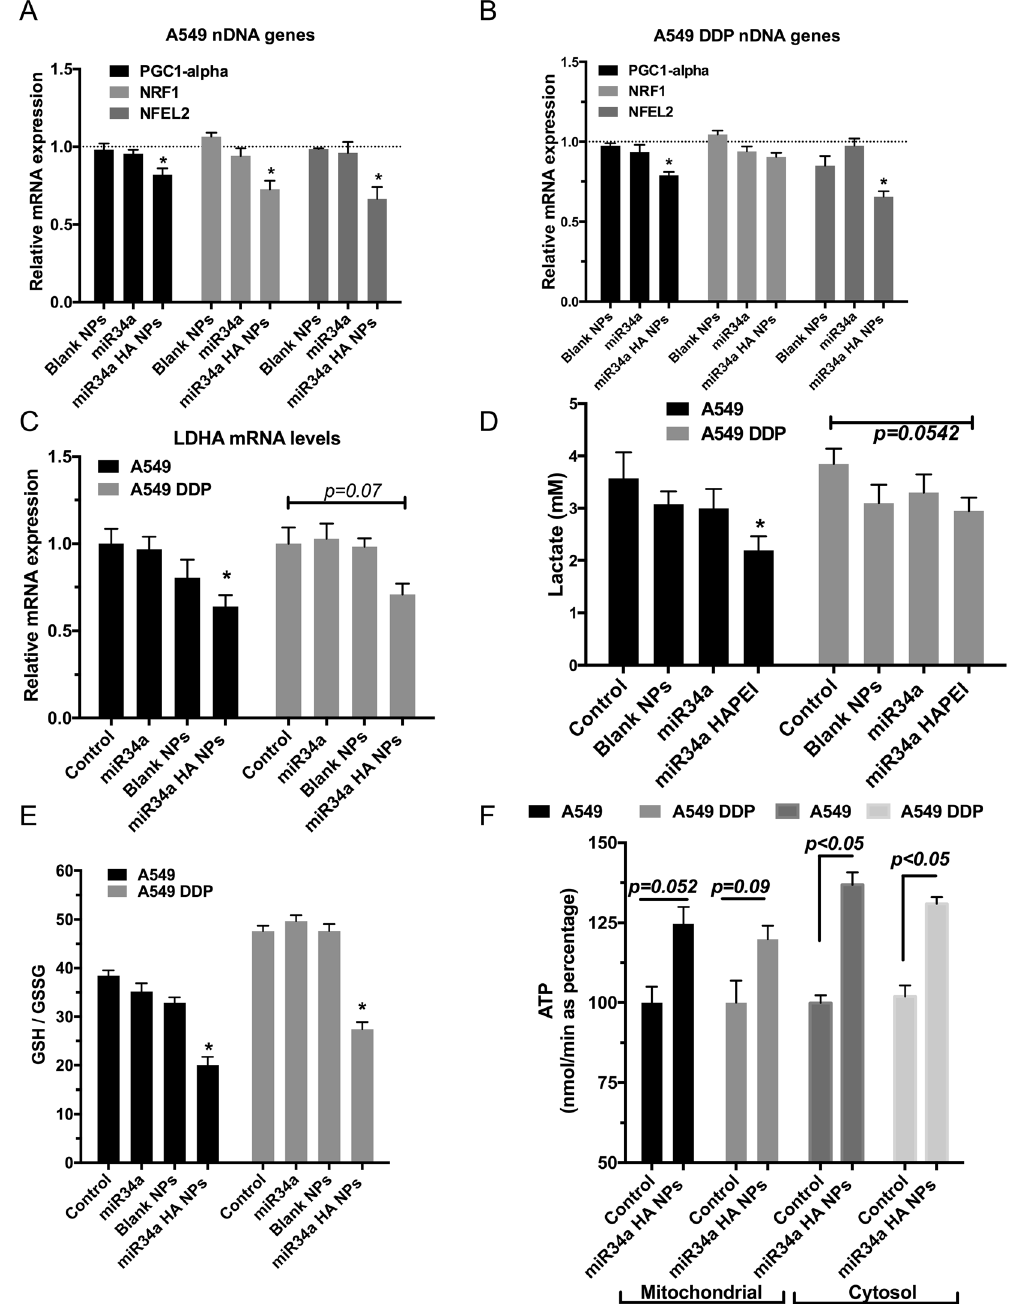
Figure 7. Effect of miR34a transfection with HA-based nanoparticles (50 nM; 24 hours) on mitochondrial bioenergetics and mitochondrial genes encoded on nuclear DNA. A quantitative real time polymerase chain reaction (qRT-PCR) assay was used to measure the levels of PGC1alpha, NRF1 and NRF2 with the ( A ) wild-type A549 cells and ( B ) cisplatin resistant A549DDP cells post-transfection with HA-PEI/HA-PEG- nanovectors encapsulated miR34a, normalized to beta-actin RNA and untreated control samples using relative quantification by delta(delta(Ct) method. ( C ) Lactate dehydrogenase mRNA levels were measured using a qRT- PCR. ( D ) Lactate activity was measured using an ELISA assay. ( E ) Ratios of reduced to oxidized Glutathione levels measured using HPLC. ( F ) Mitochondrial and Cytoplasmic ATP levels measured using ELISA assay. Blank NPs–Blank HA-PEI/HA-PEG nanoparticles, miR34a - Naked miR34a without encapsulation, miR34a HA-NPs–microRNA34a encapsulated in HA-PEI/HA-PEG nanoparticles. Results are expressed in units (mean + / − standard error of mean [SEM]); * indicates comparison against control = 1. One-way ANOVA followed by Post-hoc t-test with multiple comparisons, * p < 0.05, ** p < 0.01; n =